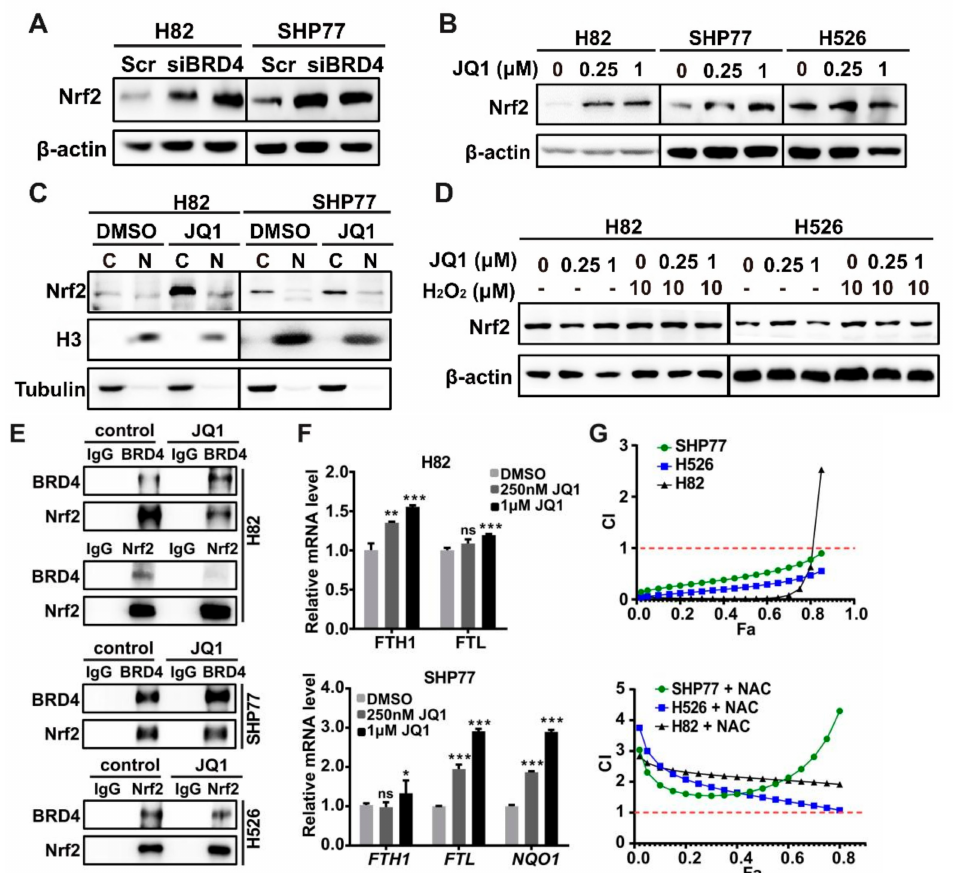
Figure 4. Blocking BRD4 results in the accumulation of Nrf2. ( A , B ) Western blot analysis of Nrf2 upon BRD4 knockdown or JQ1 treatment ( B ) in H82 and SHP77 cells. ( C ) Western blot analysis indicating the distribution of Nrf2 upon JQ1 treatment in H82 and SHP77 cells Tubulin serves as a reference protein in the cytoplasm and H3 as a reference protein in the nucleus. ( D ) Western blot analysis of Nrf2 in H82 and H526 cells with or without H 2 O 2 after treatment with JQ1. ( E ) Co-IP experiments demonstrating the interaction of BRD4 and Nrf2 upon JQ1 treatment. ( F ) RT-qPCR analysis of FTH1, FTL, and NQO1 upon JQ1 treatment in H82 and SHP77 cells. ( G ) CellTiter-Glo Luminescent assays demonstrating the effects of the combination of ATRA and JQ1 with (lower panel) or without NAC (upper panel) in H82, SHP77, and H526 cells. ns > 0.05; * p < 0.05; ** p < 0.01; *** p < 0.001 (Student’s t